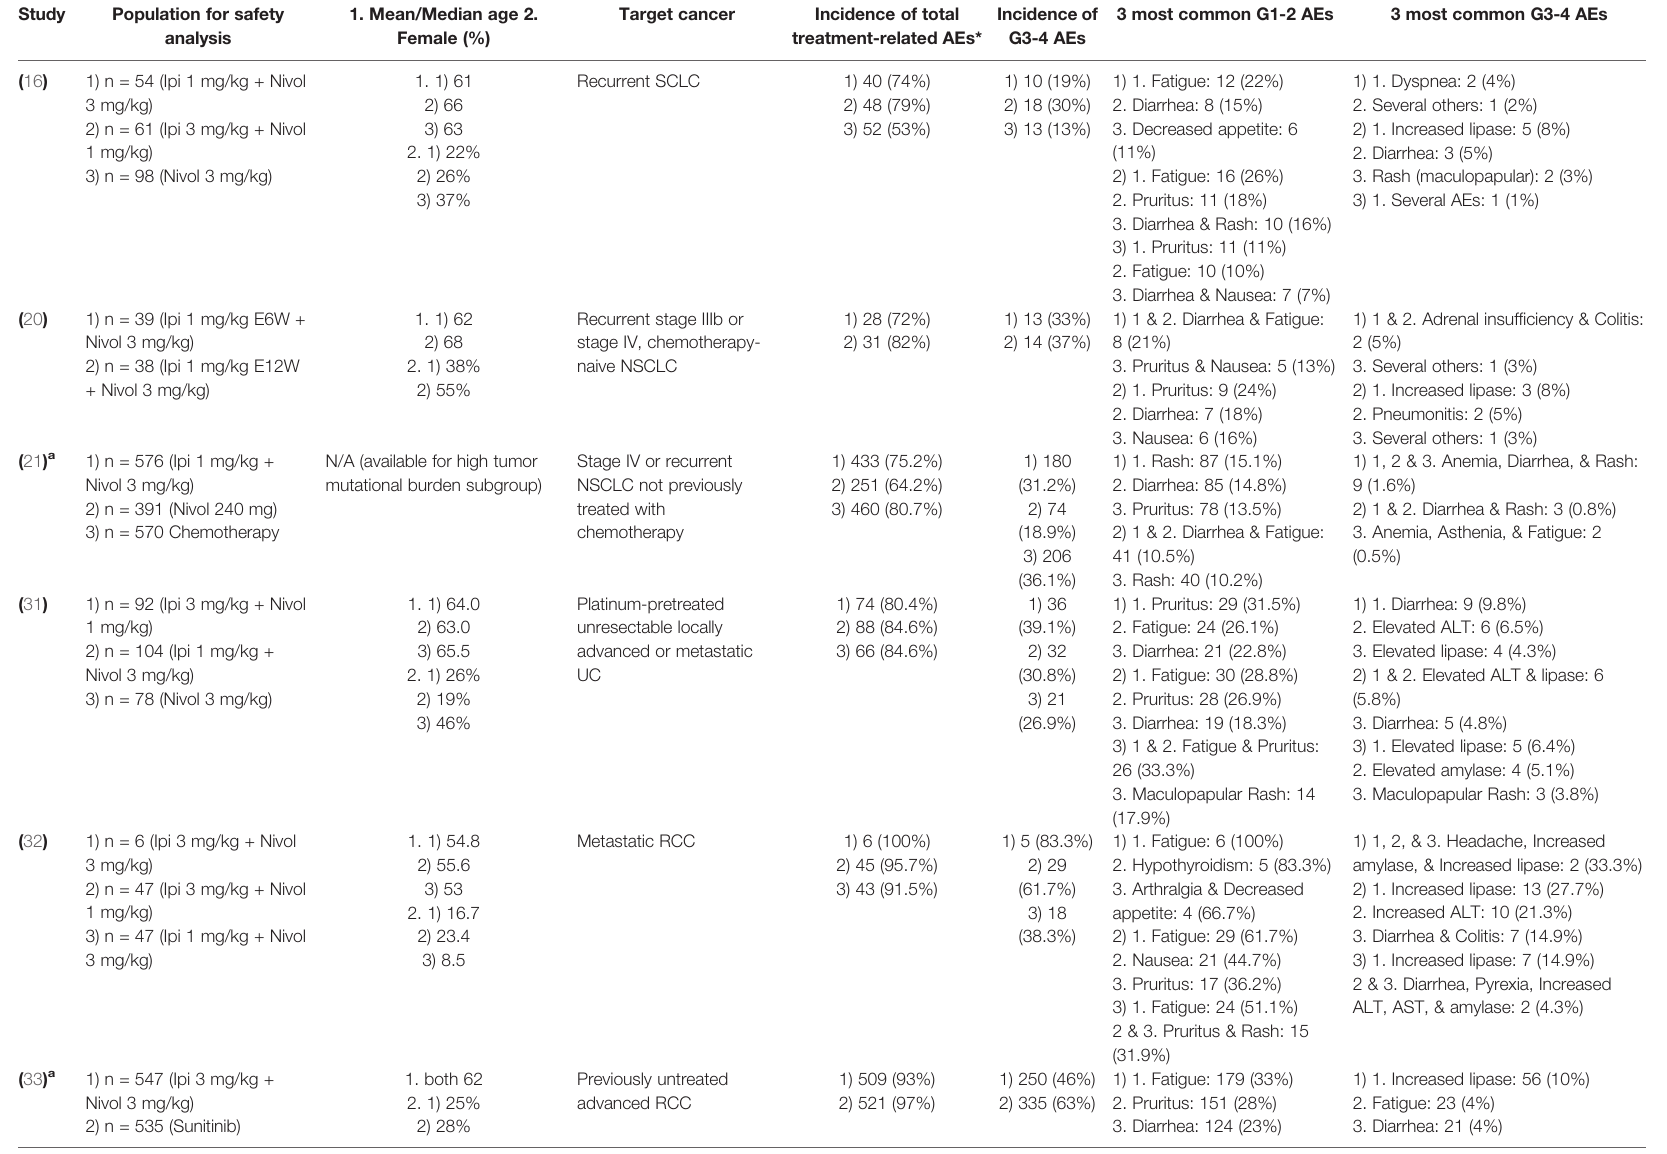
TABLE 3 | Safety pro fi le of the studies involving ipilimumab and